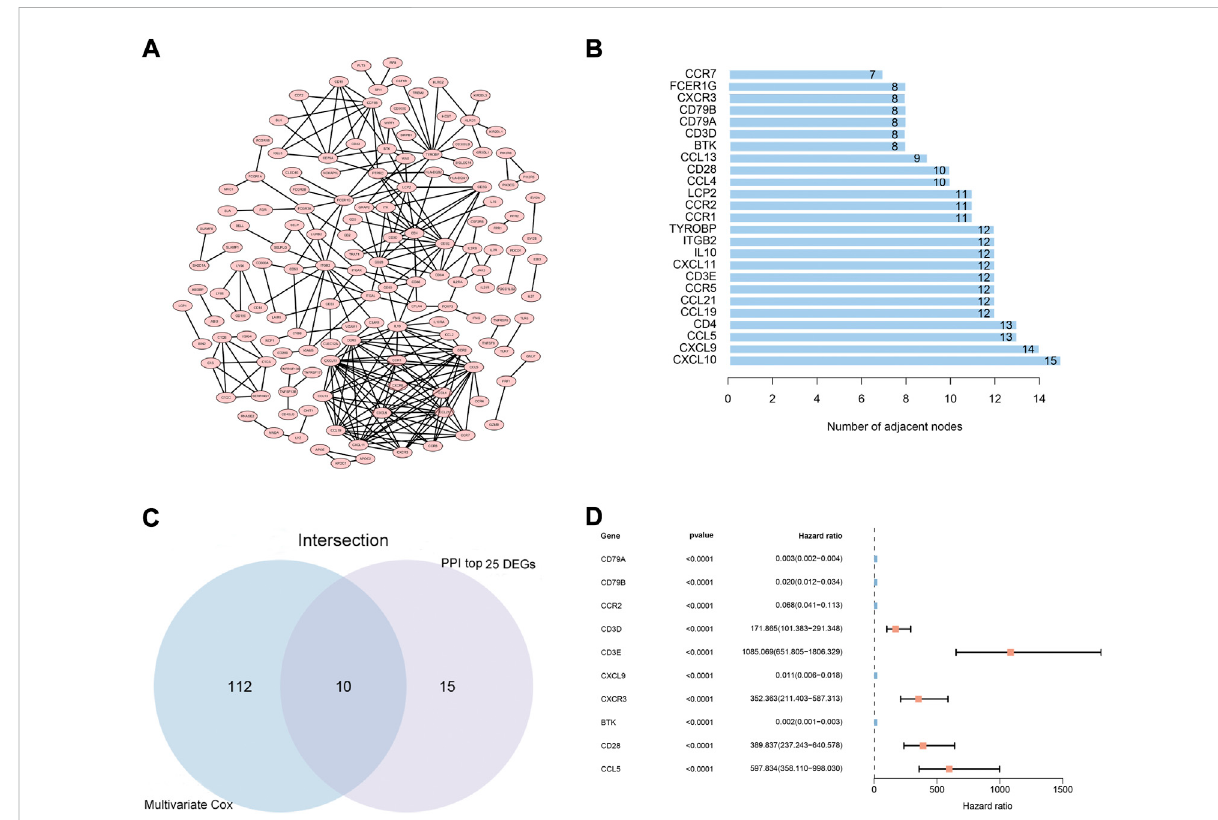
FIGURE 3 PPI network and multivariate Cox regression analysis. (A) PPI network constructed using nodes with interaction con fi dence value > 0.95, as visualizedbyCytoscape. (B) Thetop25DEGs,orderedbythenumberofnodes. (C) VenndiagramofthecommonintersectionDEGsbasedonthetop 25 DEGs in the PPI network and the most signi fi cant DEGs with p < 0.001 in multivariate Cox regression analysis. (D) Multivariate Cox regression analysis of 10 common intersecting